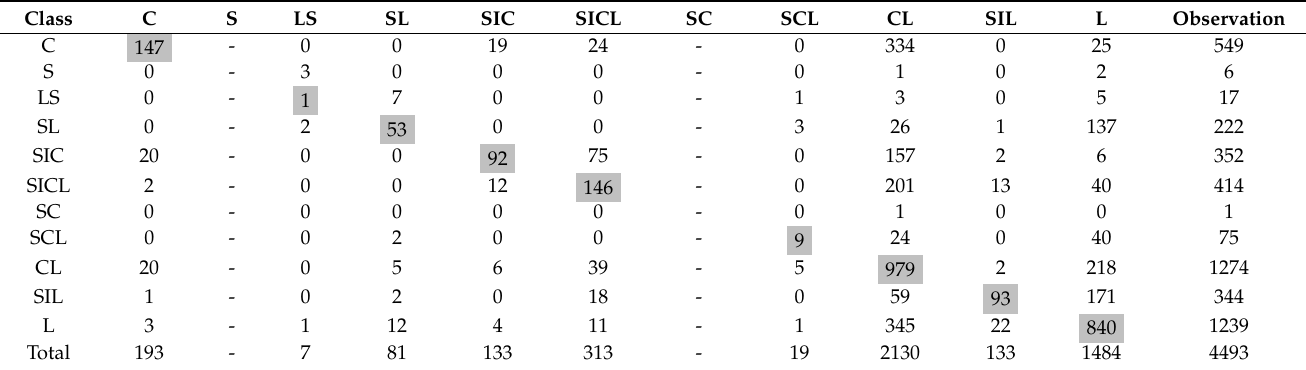
Table 8. Confusion matrix of actual and predicted soil texture